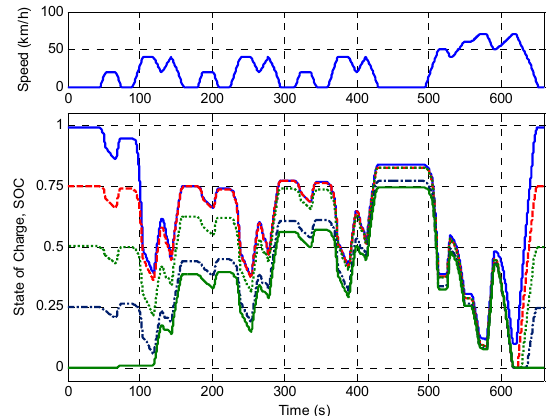
Figure 10. State-of-Charge (SOC) Trajectories with Different Initial Condition.